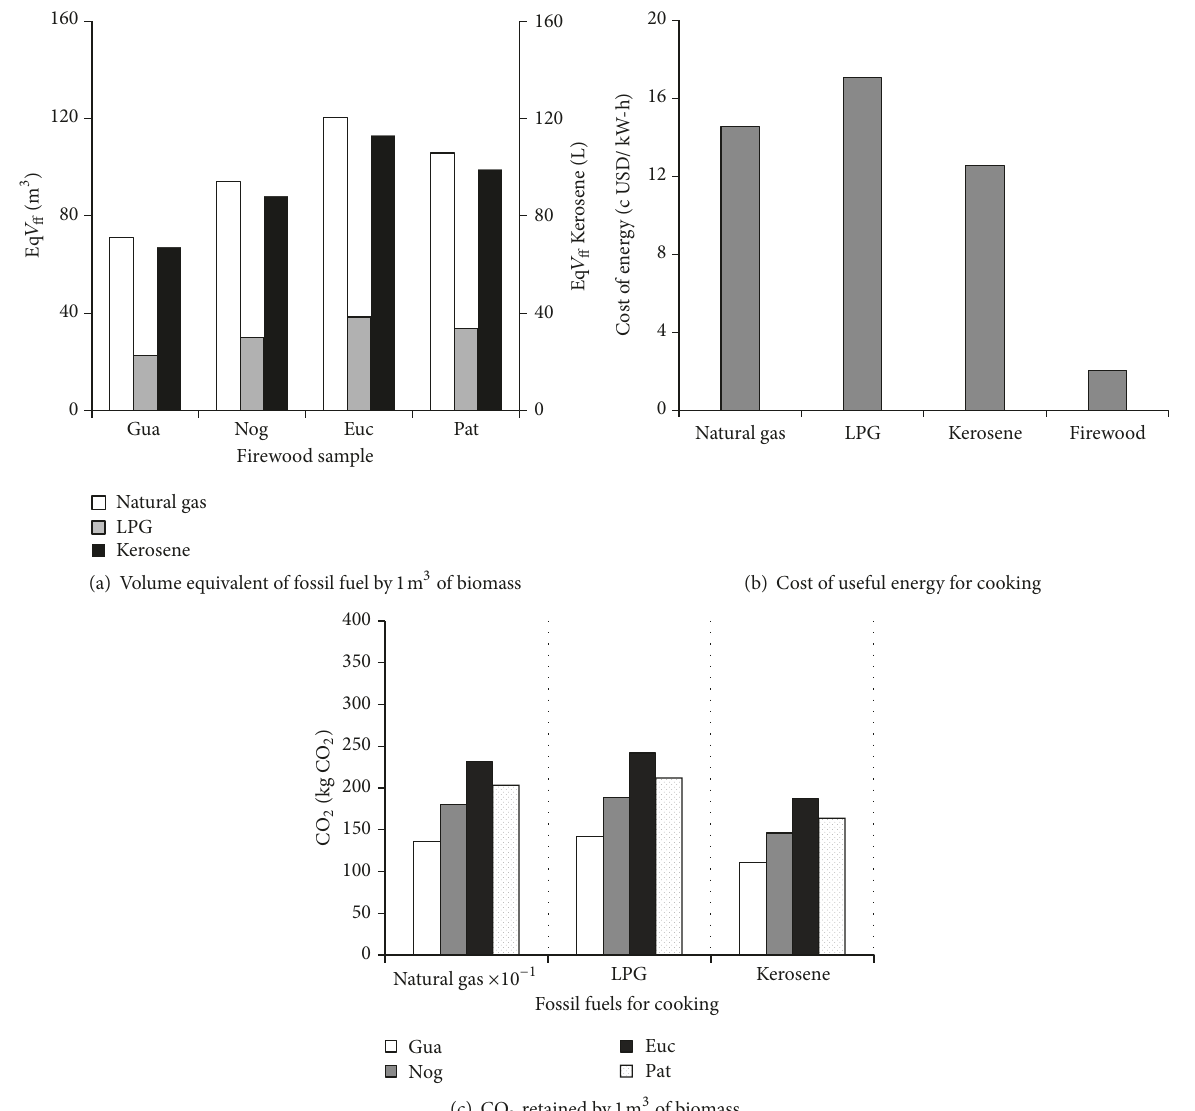
Figure 8: Comparison of volume equivalent, emissions, and costs between firewood species and fossil fuels used for cooking in